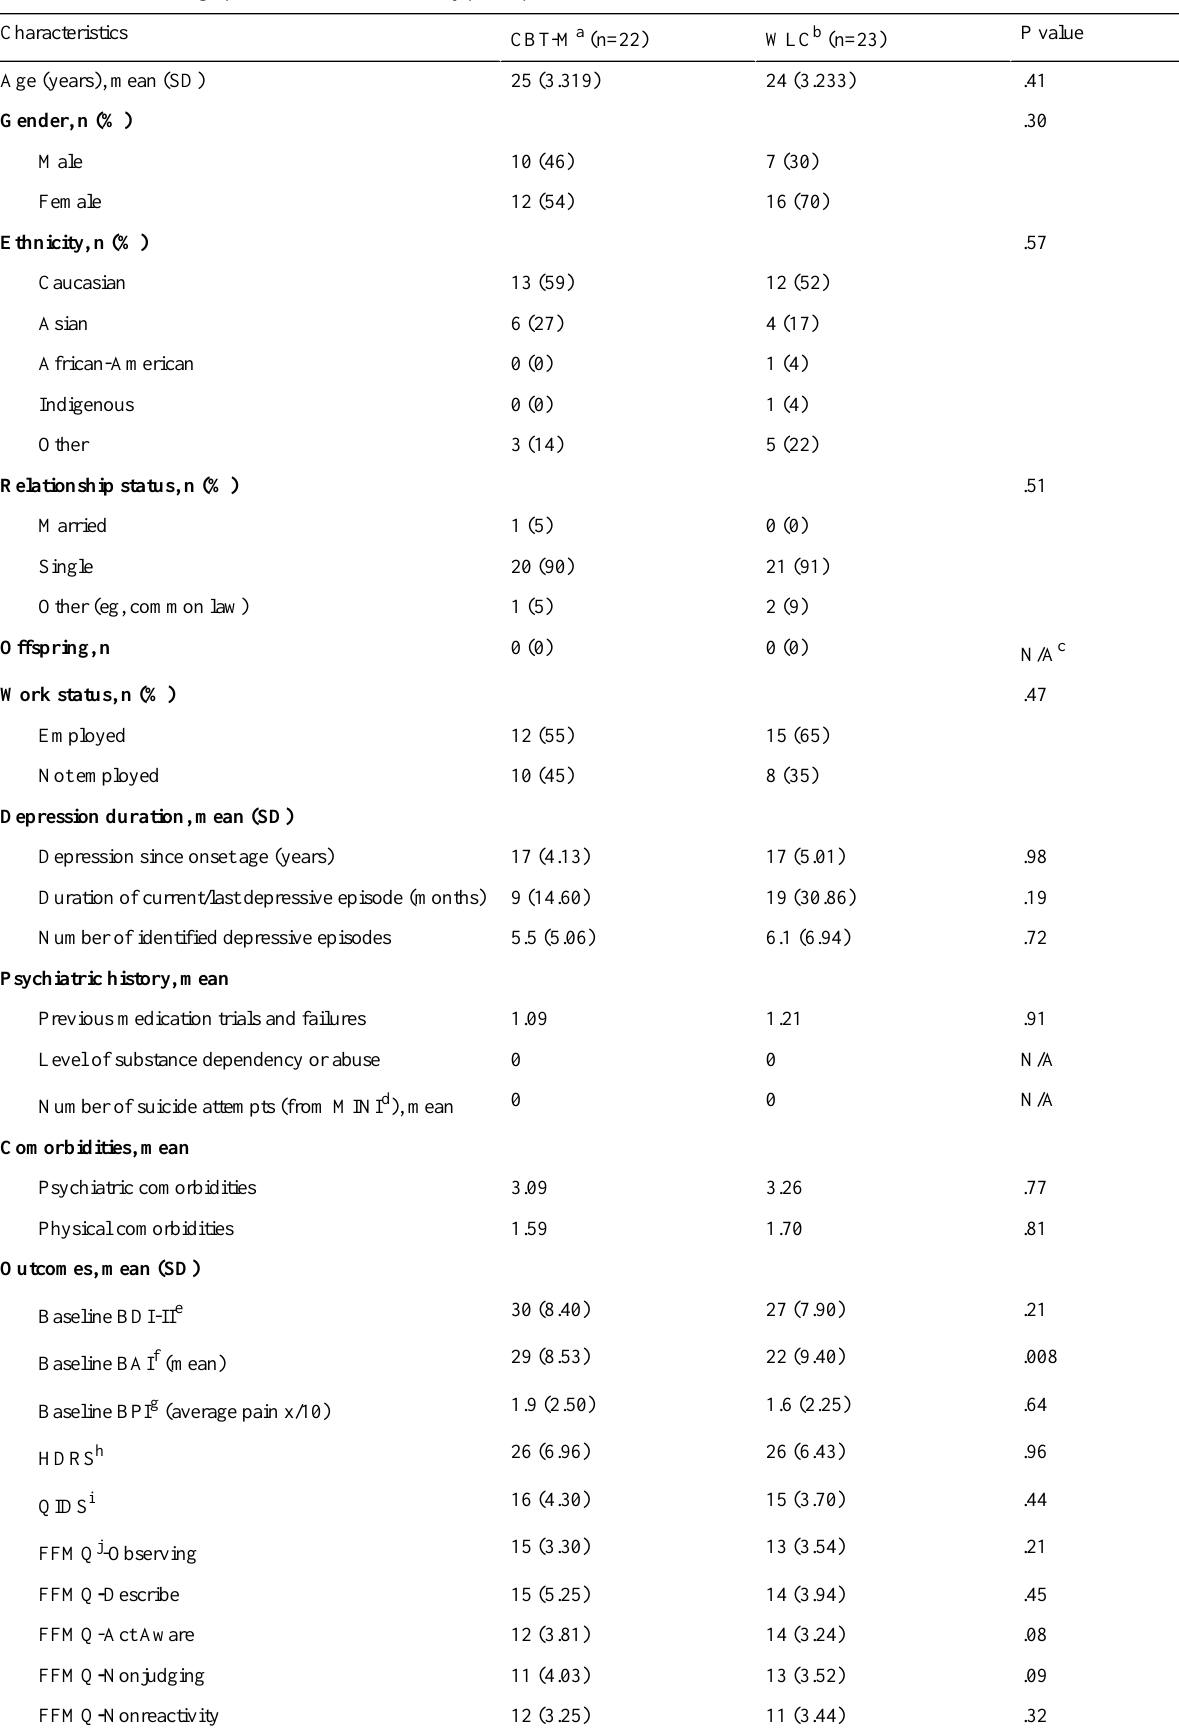
Table 1. Baseline demographic characteristics of study